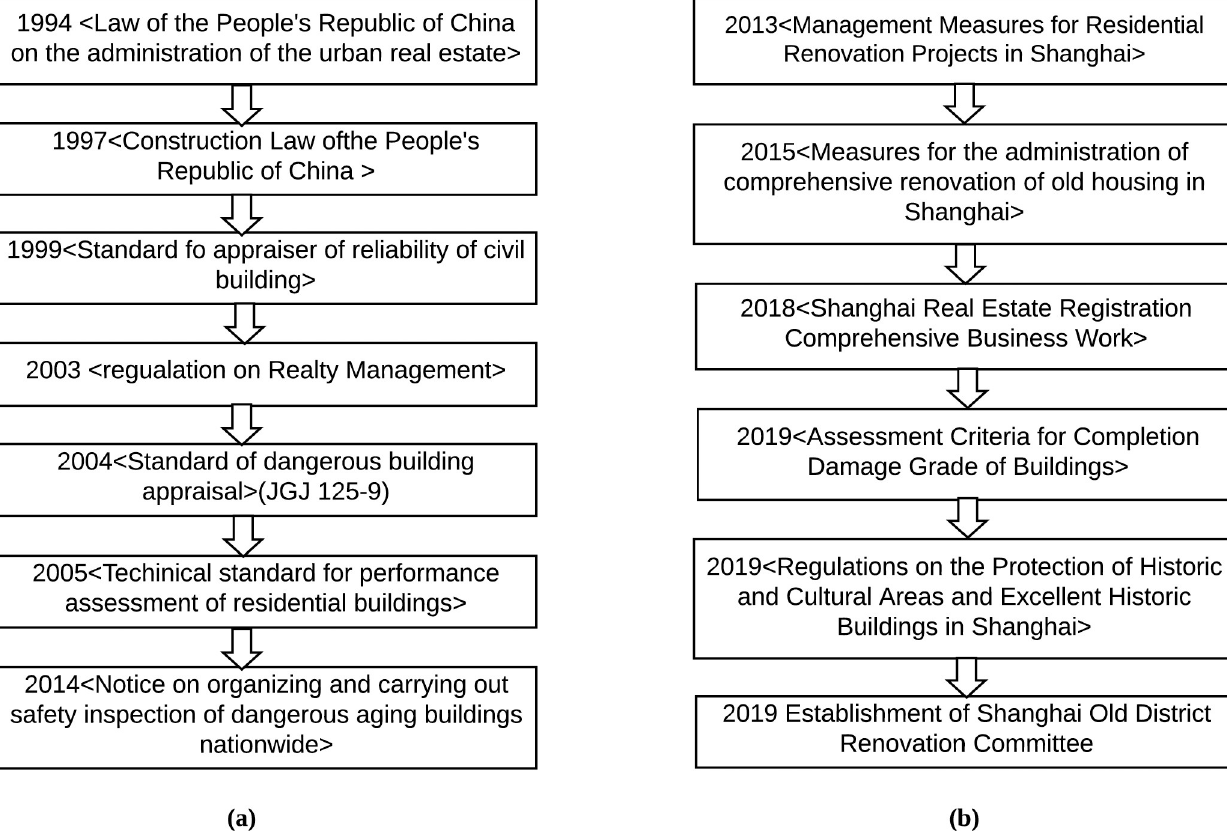
PLOS ONE | https://doi.org/10.1371/journal.pone.0227871 January 24,